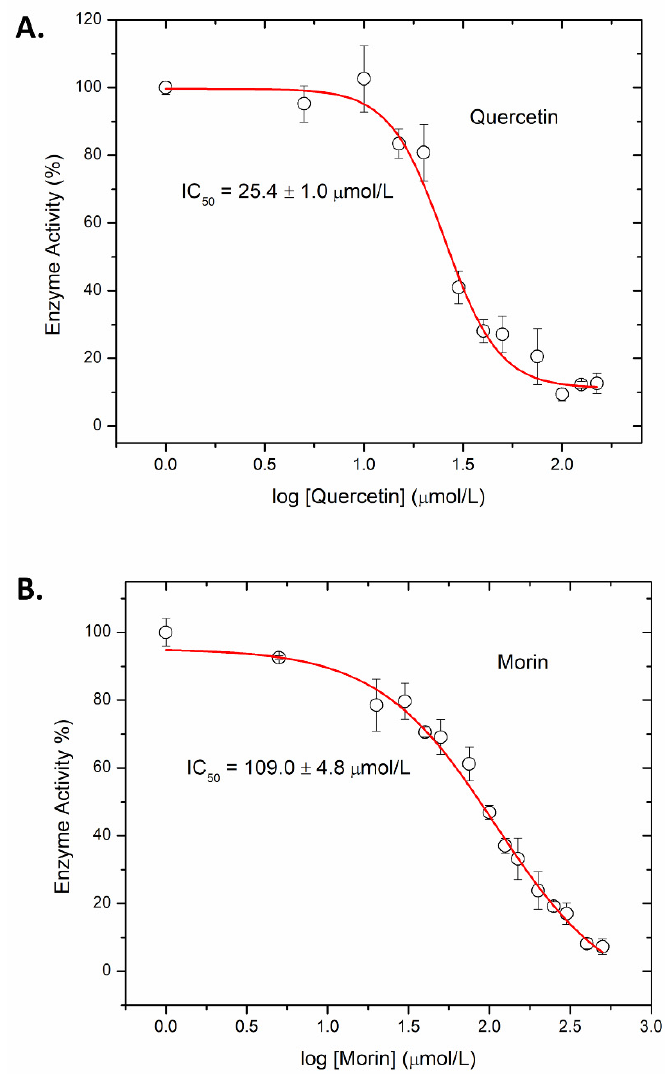
Figure 3. IC 50 dose–response curves (representative) for Plx2A GH activity. The concentration of inhibitor that reduced the Plx2A GH enzyme activity by 50% (IC 50 value) was determined as described in the Material and Methods section. ( A ) Quercetin dose–response curve, ( B ) Morin dose–response curve. Each data point was collected in triplicate and averaged (mean ± S.D.) and the experiment was repeated three times. Eight compounds showed strong inhibitory activity against Plx2A GH activity (Table 1) with four flavonoids exhibiting IC 50 values less than 50 µ